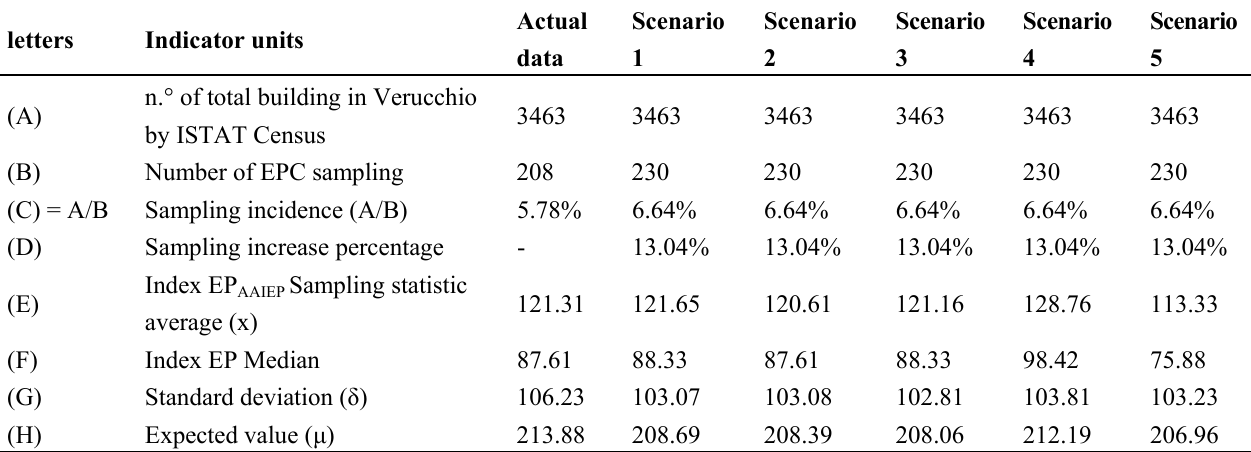
Table 9. Statistical analysis indicator and